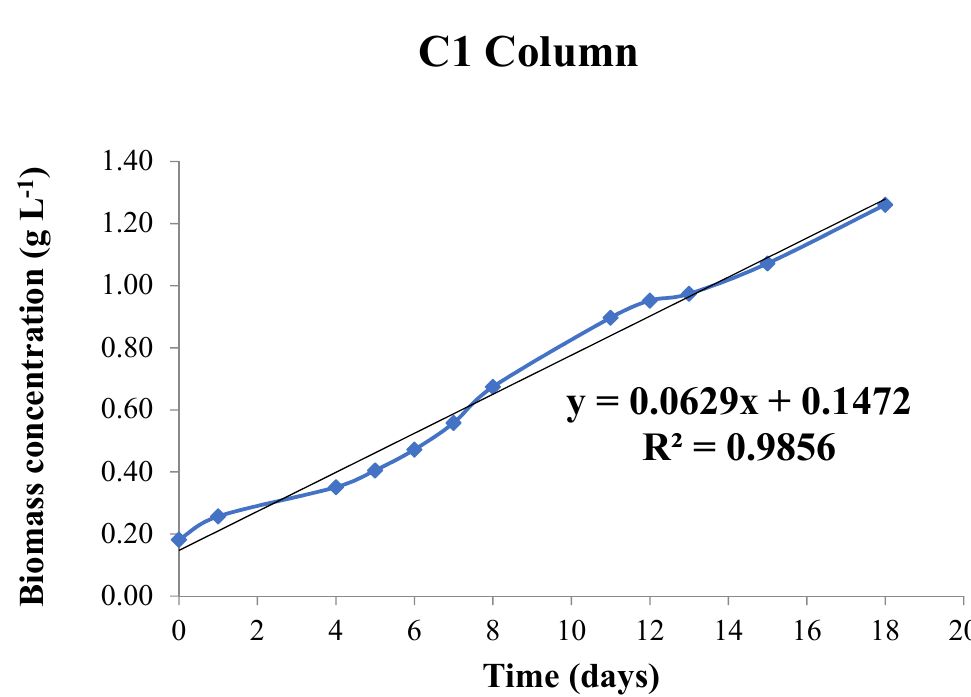
Figure 8. Growth curve of “La Orden” species with fertilizer medium in column photobioreactor of the pilot plant.